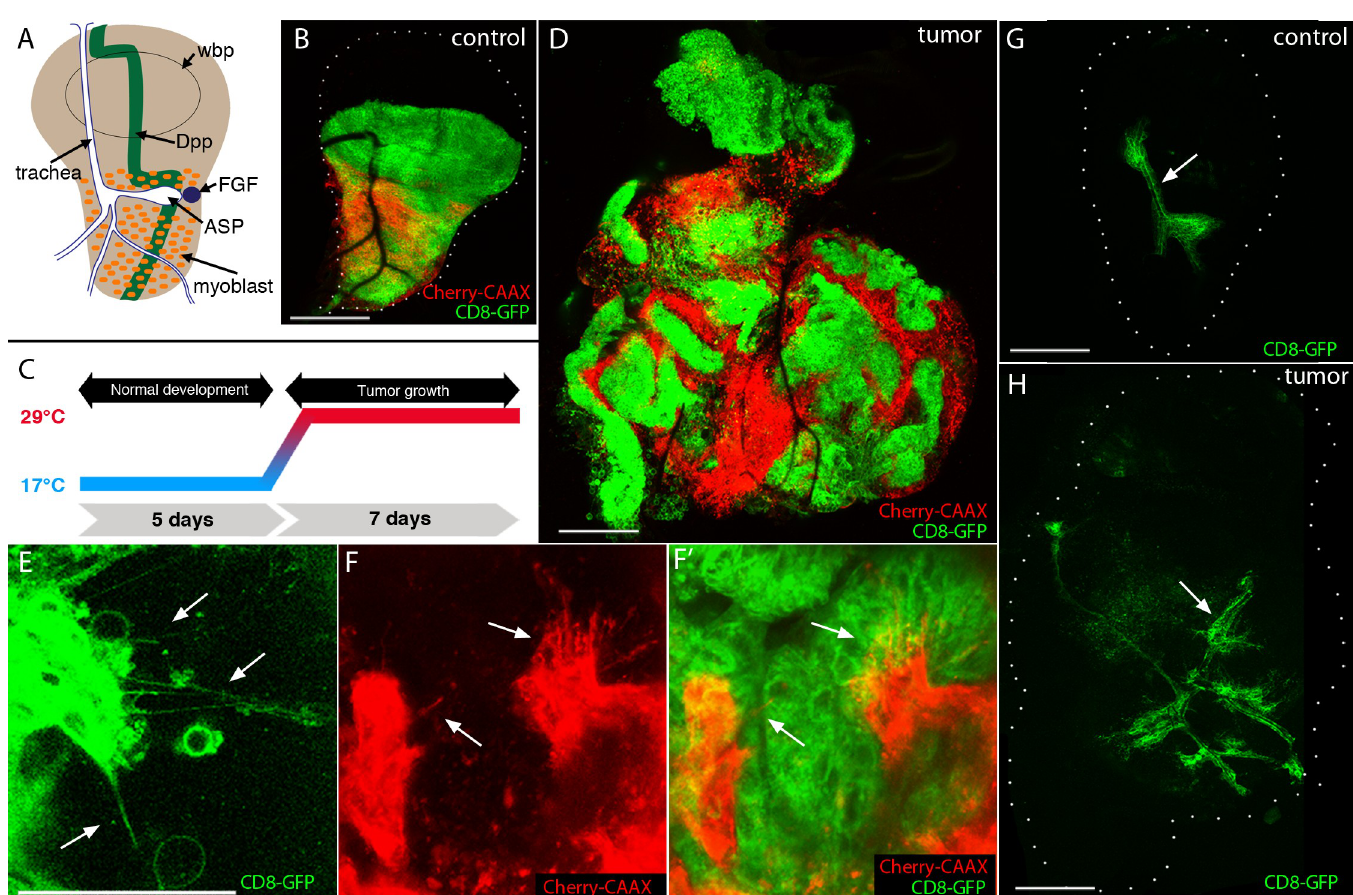
Fig 1. Cytonemes in EGFR-Pcn i tumor and tumor-associated cells. (A) Cartoon of a 3 rd instar larval wing disc with wing blade primordia (wbp), disc-associated myoblasts (orange), trachea (white, outlined in blue) and air sac primordium (ASP), Dpp expressing cells (green stripe), Bnl expressing cells (blue circle). (B) Control wing disc expressing CD8:GFP in dorsal driven epithelial cells ( ap-Gal4 ; green), and mCherry:CAAX in myoblasts (( 15B03-lexA ; red). (C) Schematic representation of tumor induction: animals developed for five days at 18˚C with Gal4 repressed by Gal80, were transferred to 29˚C to induce Gal4 and tumor growth for seven days (unless indicated otherwise). (D-F) Unfixed EGFR-Pcn tumor model wing discs. (D) Wing disc with tumor cells (CD8:GFP; green) and myoblasts (mCherry:CAAX; red). Genotype: ap-Gal4 , UAS-psq RNAi /115B03-lexA , lexO-Cherry-CAAX;UAS-EGFR , tub-Gal80 ts /UAS-CD8 : GFP . Scale bars: 100 μ m. (E) Cytonemes in the tumor epithelial cells (green, arrows); genotype: ap-Gal4 , UAS-psq , tub-Gal80 ts /UAS-CD8 : GFP . (F-F’) Cytonemes in myoblasts (red, arrows) extend towards epithelial cells RNAi /+;UAS-EGFR (green); genotype: ap-Gal4 , UAS-psq , lexO-Cherry-CAAX;UAS-EGFR , tub-Gal80 ts /UAS-CD8 : GFP ; scale bars: 50 μ m. (G-H) Unfixed wing discs with RNAi /115B03-lexA marked tracheal cells (green, arrows); (G) control, genotype: btl-LHG , lexO-CD2-GFP ; (H) EGFR-Pcn tumor, genotype: ap-Gal4 , UAS-psq RNAi /btl-LHG , lexO-CD2-GFP; UAS-EGFR , tub-Gal80 ts /+ . Excessive tracheal growth and ectopic branches indicated by arrows; scale bars: 100 μ m.